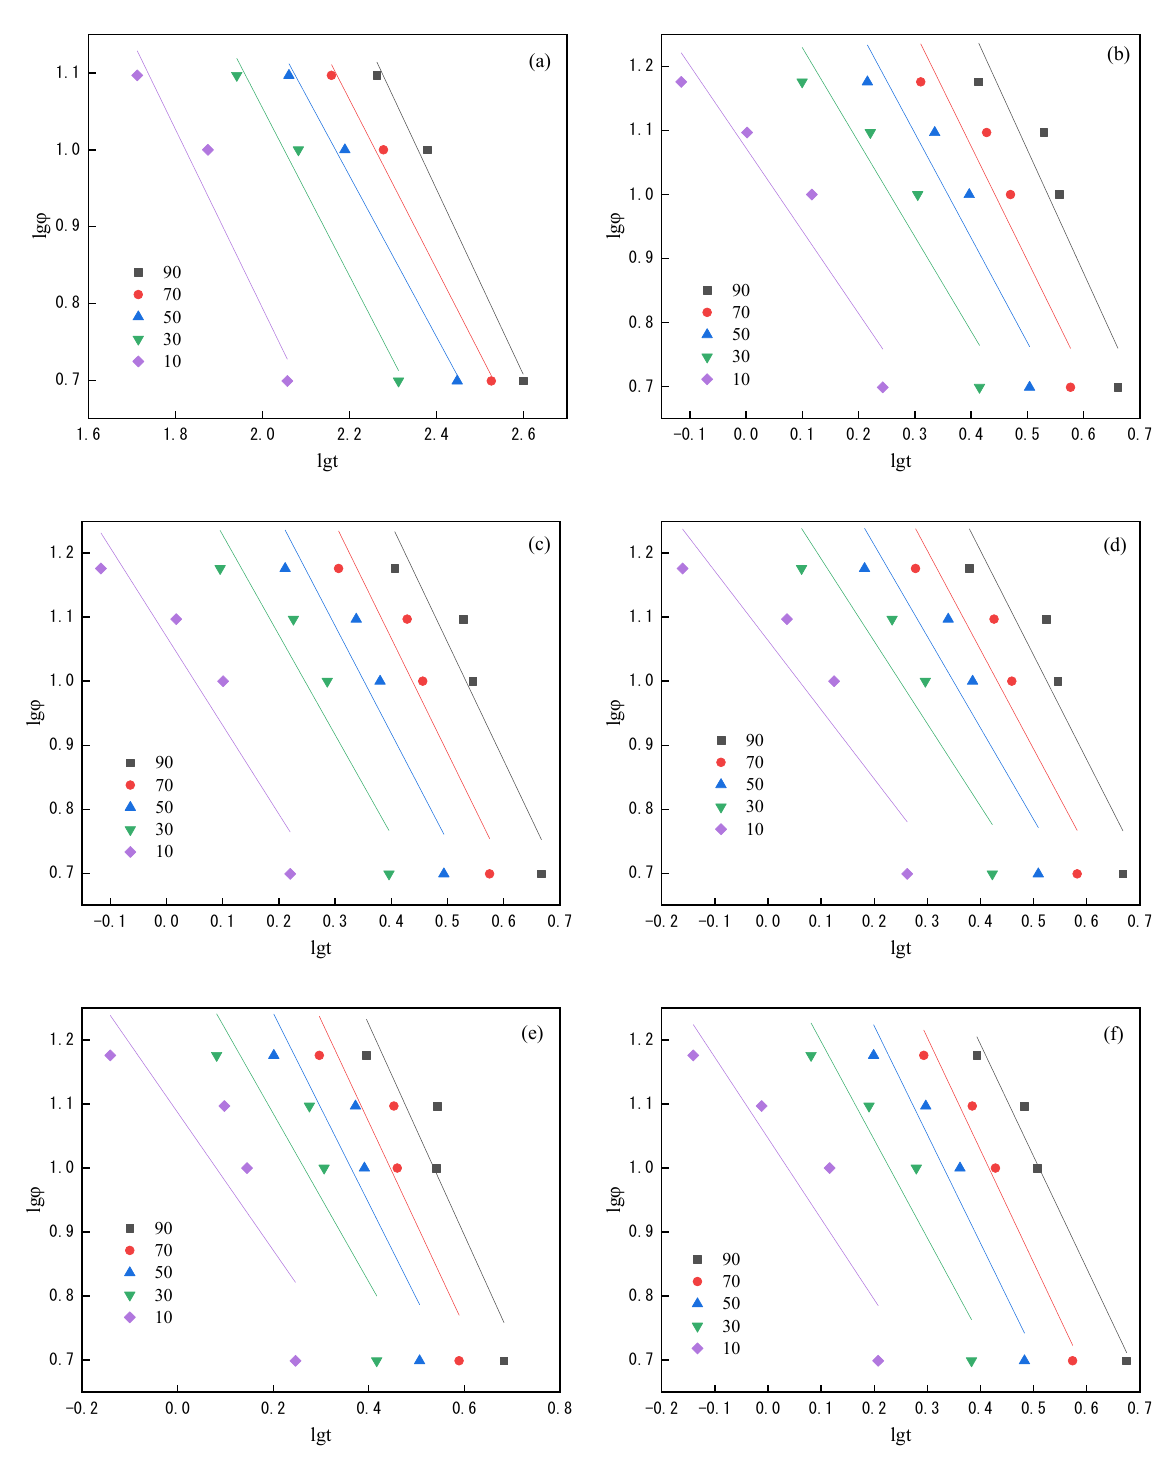
Figure 6. Relationship between lg Φ and lg t at relative crystallinity of 10%, 30%, 50%, 70% and 90%. ( a ) PET; ( b ) PSLDH 0.01 wt%; ( c ) PSLDH 0.03 wt%; ( d ) PSLDH 0.05 wt%; ( e ) PSLDH 0.07 wt%; ( f ) PSLDH 0.1